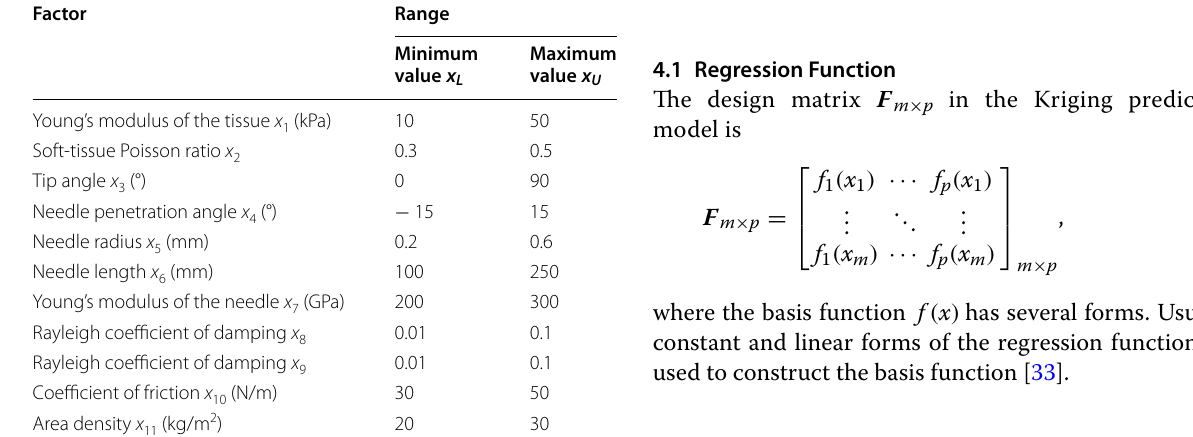
Table 1 Factors and range of values in the soft tissue deformation